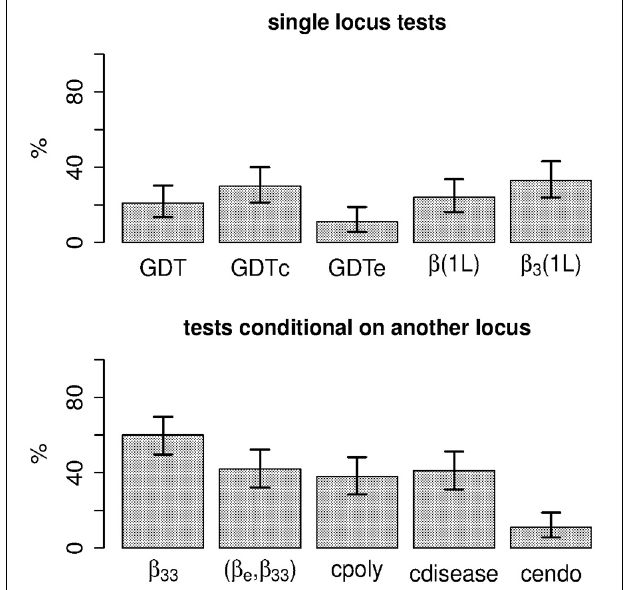
FIGURE 2 | Power of various within-family score tests to detect locus 2. See text for definitions of the acronyms of the tests. For tests conditional on another locus, subject pairs were weighted using expression